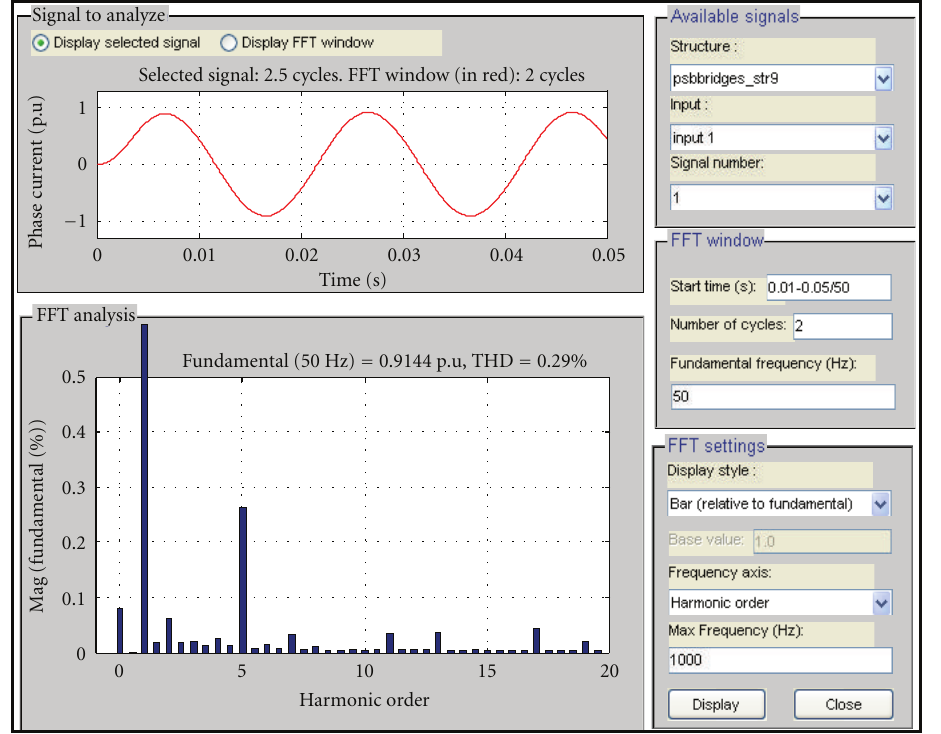
Figure 13: FFT analysis for simulation showing the THD and harmonic spectrum of load